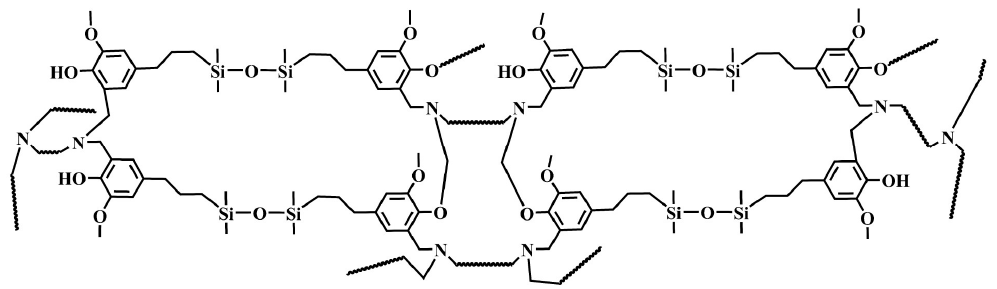
Figure 8. The possible chemical structures of final cured polybenzoxazine.